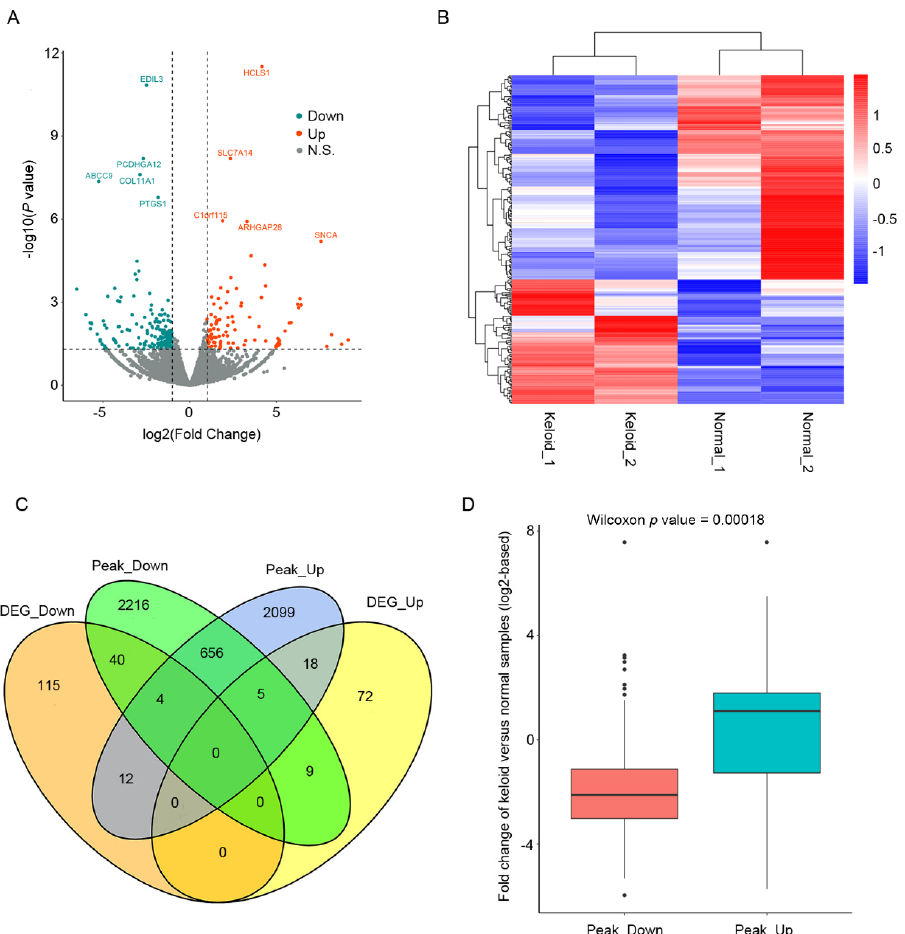
Figure 2. Integrated analysis of chromatin accessibility and transcriptional landscape uncovered influence of chromatin state transformation on gene expression alteration in keloid formation. ( A ) Volcano plot showing the log2-based fold change (X-axis) and significance (Y-axis, − log10( p value)) of differential gene expression analysis between keloids and normal DF samples. Blue and red dots represent genes that are significantly down- and upregulated in keloid DF relative to normal DF, respectively. Dark grey dots are non-significantly differential expression genes. ( B ) Heatmap illustrating the z-score normalized expression values of the differentially expressed genes (DEGs) in normal and keloid DF samples. ( C ) Overlaps between DEGs and differentially accessible chromatin region-associated genes stratified by their changes in keloid DF relative to normal DF. Peak_Down and Peak_Up represent genes annotated by chromatin regions that are tighter and looser in keloid DF compared with normal DF, respectively. DEG_Down and DEG_Up are genes that are significantly down- and upregulated in keloid DF compared with normal DF, respectively. ( D ) Distribution of log2-based fold changes of Peak_Down and Peak_Up genes in keloid DF relative to normal DF.